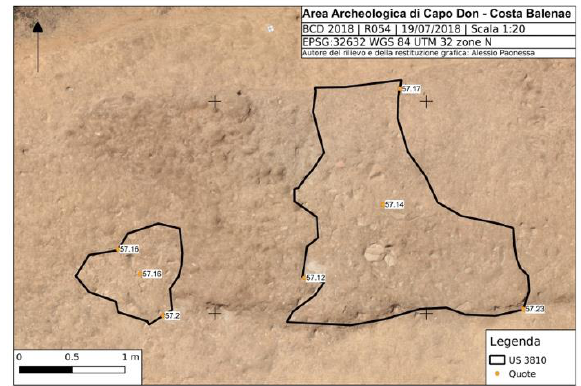
Figure 2. Example orthophoto mosaic for a single a Stratigraphic unite.